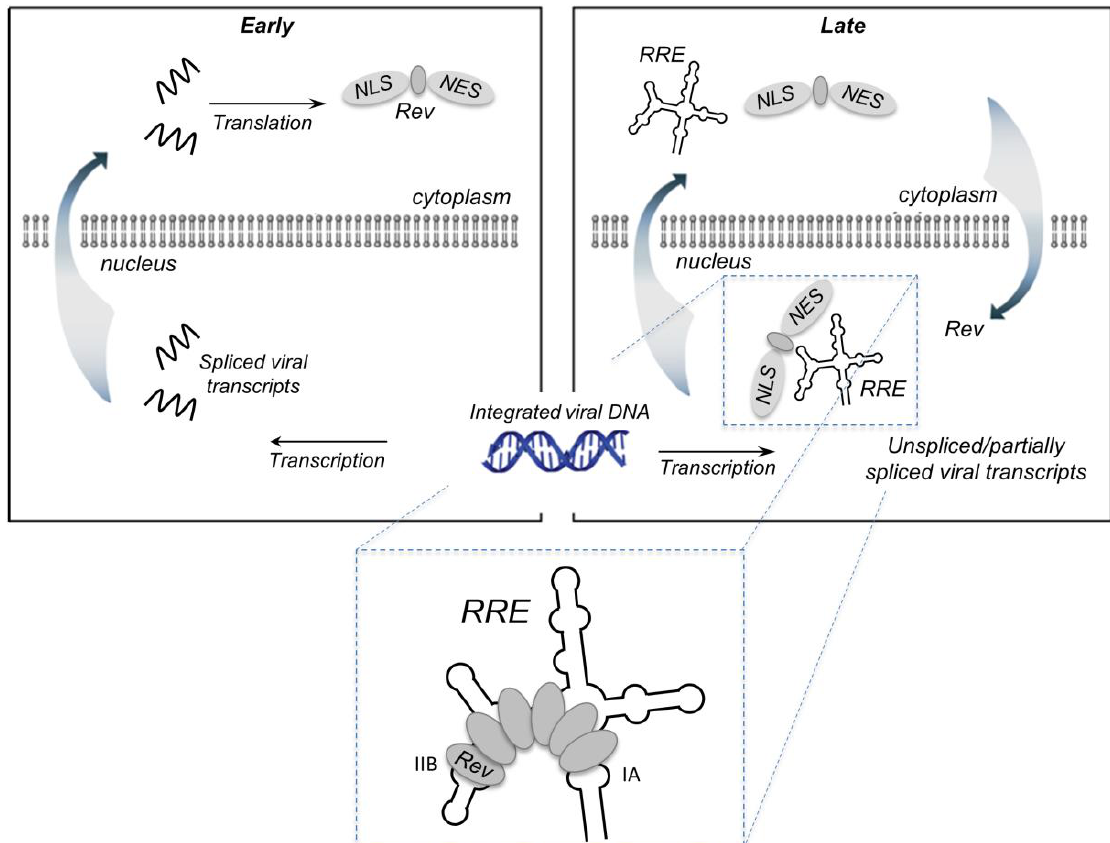
Figure 1. Rev-mediated nucleocytoplasmic transport of HIV-1 RNA containing the